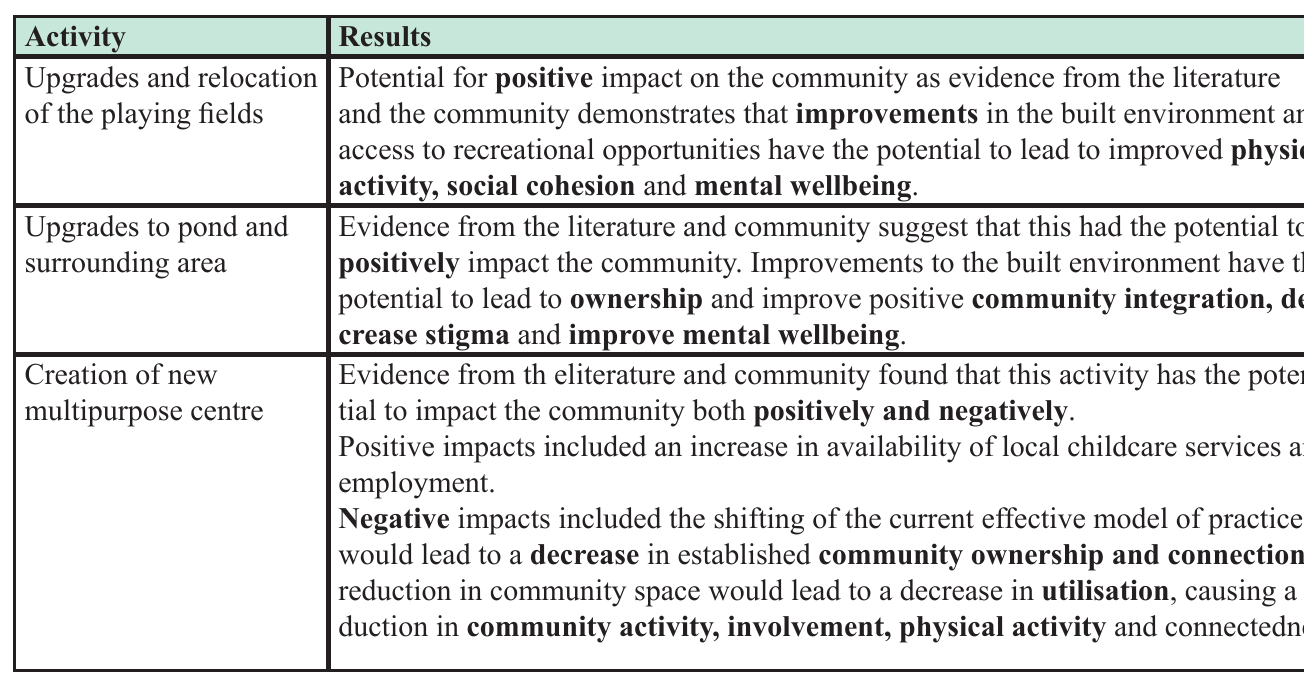
Table 2: Summary of key